Question: Does the plotted quantity increase or decrease?
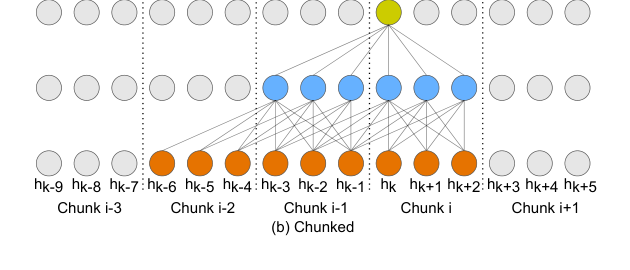
Answer: increasing